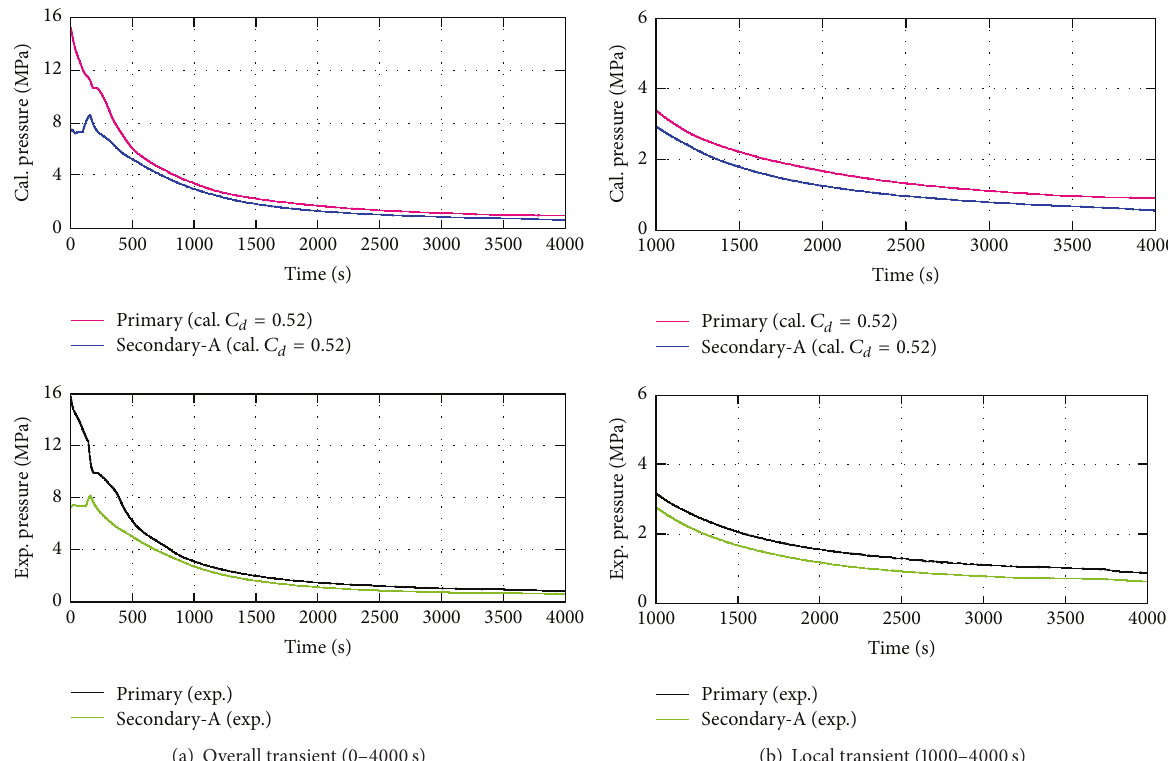
Figure 9: LSTF and RELAP5 results for primary and SG secondary pressures in loop-A in case of release of dissolved gas.